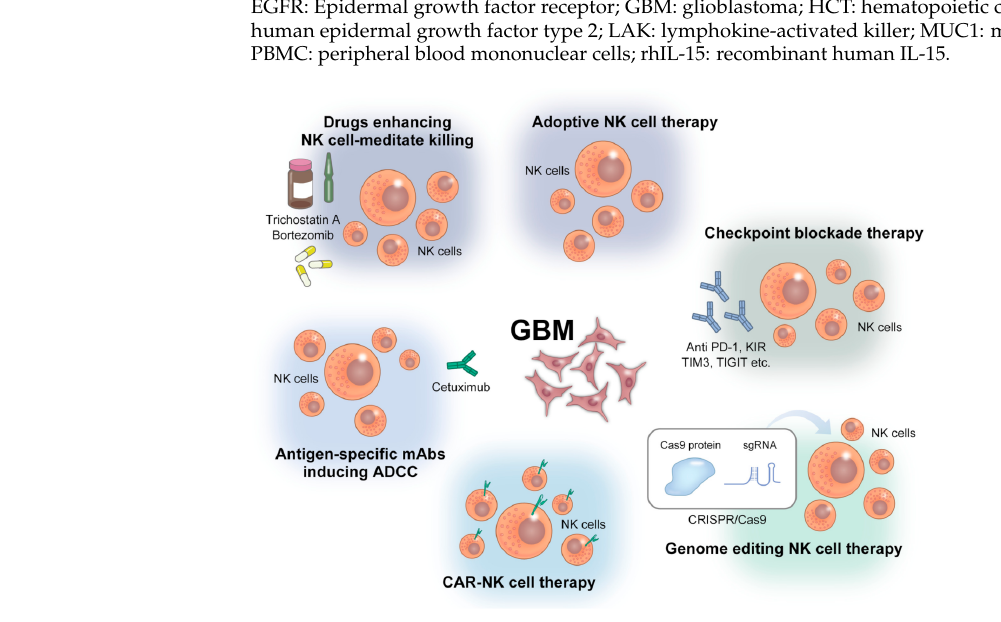
Figure 3. Strategies of NK cell-based immunotherapy against GBM. ADCC: Antibody-dependent cellular cytotoxicity, PD-1: programmed cell death 1, KIR: killer cell immunoglobulin-like receptors, TIGIT: T-cell immunoreceptor with immunoglobulin and ITIM domains, TIM3: T-cell immunoglobu- lin mucin family member